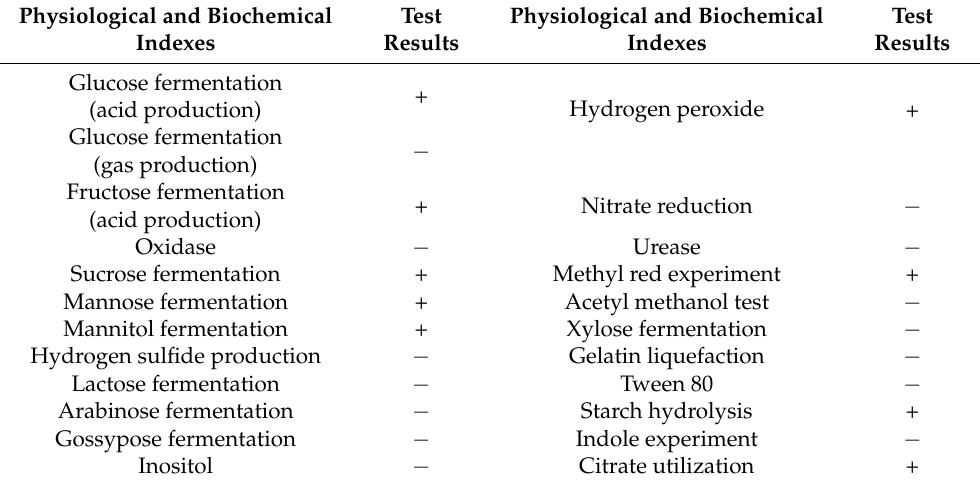
Table 2. Physiological and biochemical characteristics of Acinetobacter baumannii DP-2. Physiological and